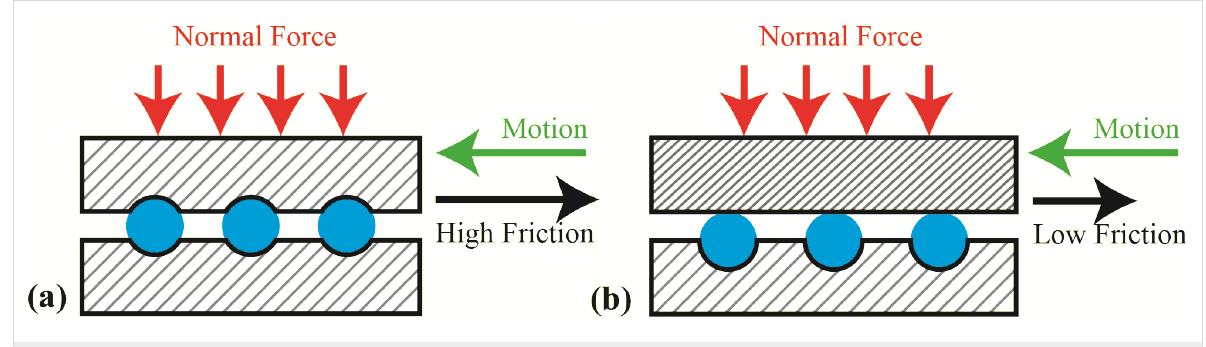
Figure 1: Friction from plowing of wear particles [16] a) materials of same hardness, b) top material harder than lower. Blue balls represent wear particles trapped between the